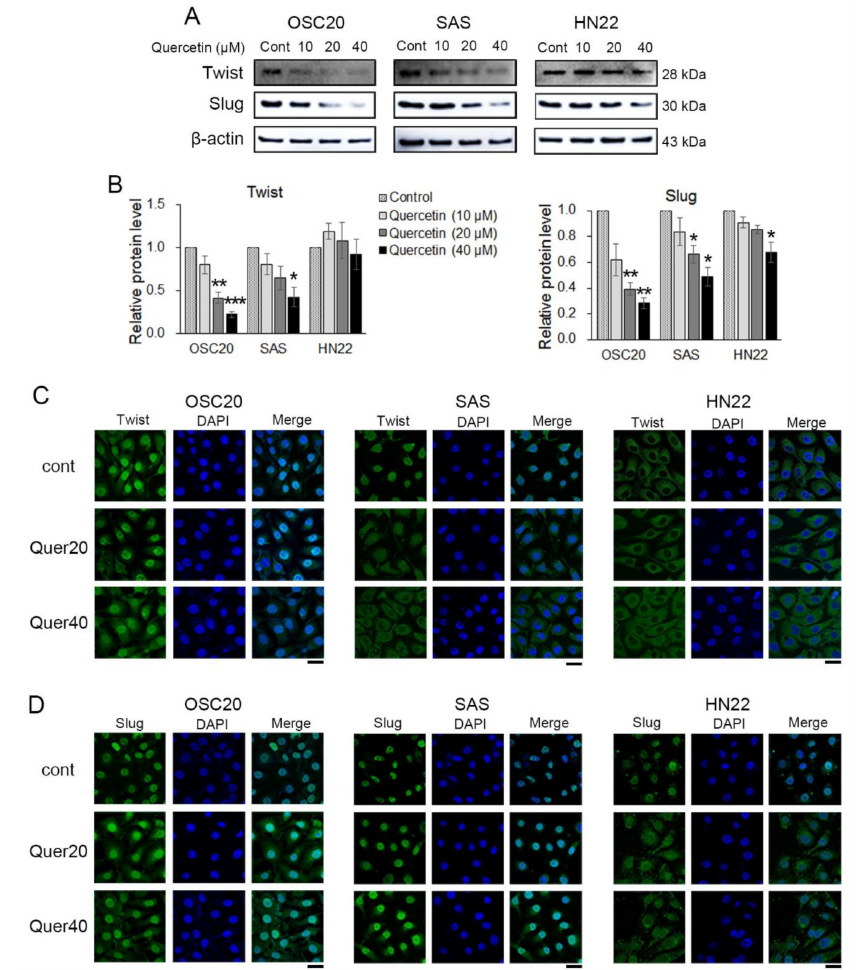
Figure 4. EMT-activating transcription factors were detected using Western blot and immunofluorescence. ( A ) The Western blot showed that quercetin downregulated EMT transcription factors at the protein level. ( B ) Quantitation of A. The band intensities of each target protein were measured using an image analyzer and presented as relative ratio. ( C ) Representative fluorescence microscopy images of Twist in OSCC cell lines. ( D ) Representative fluorescence microscopy images of Slug in OSCC cell lines. Scale bars: 20 µ M. Data are the means ± SEM. * p < 0.05, ** p < 0.01, and *** p < 0.001 vs. the corresponding control (quercetin 0 µ